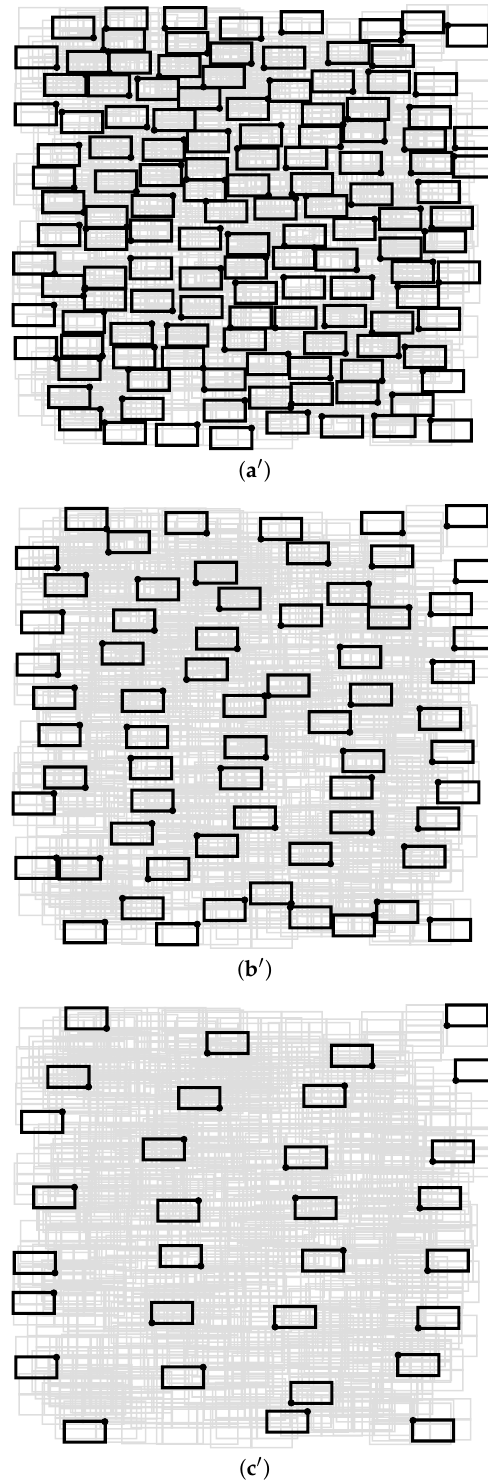
Figure 7. Different labelings for an instance with 400 points in a square of size 20 × 20 (left side) and in a square of size 10 × 10 (right side). Selected labels are displayed with black boundaries, unselected labels with gray boundaries. ( a , a (cid:48) ) maximum-weight solution; ( b , b (cid:48) ) solution of the extended model; Γ is a square of size 1 × 1 and K Γ = 2; ( c , c (cid:48) ) solution of the extended model; Γ is a square of size 2 × 2 and K Γ =